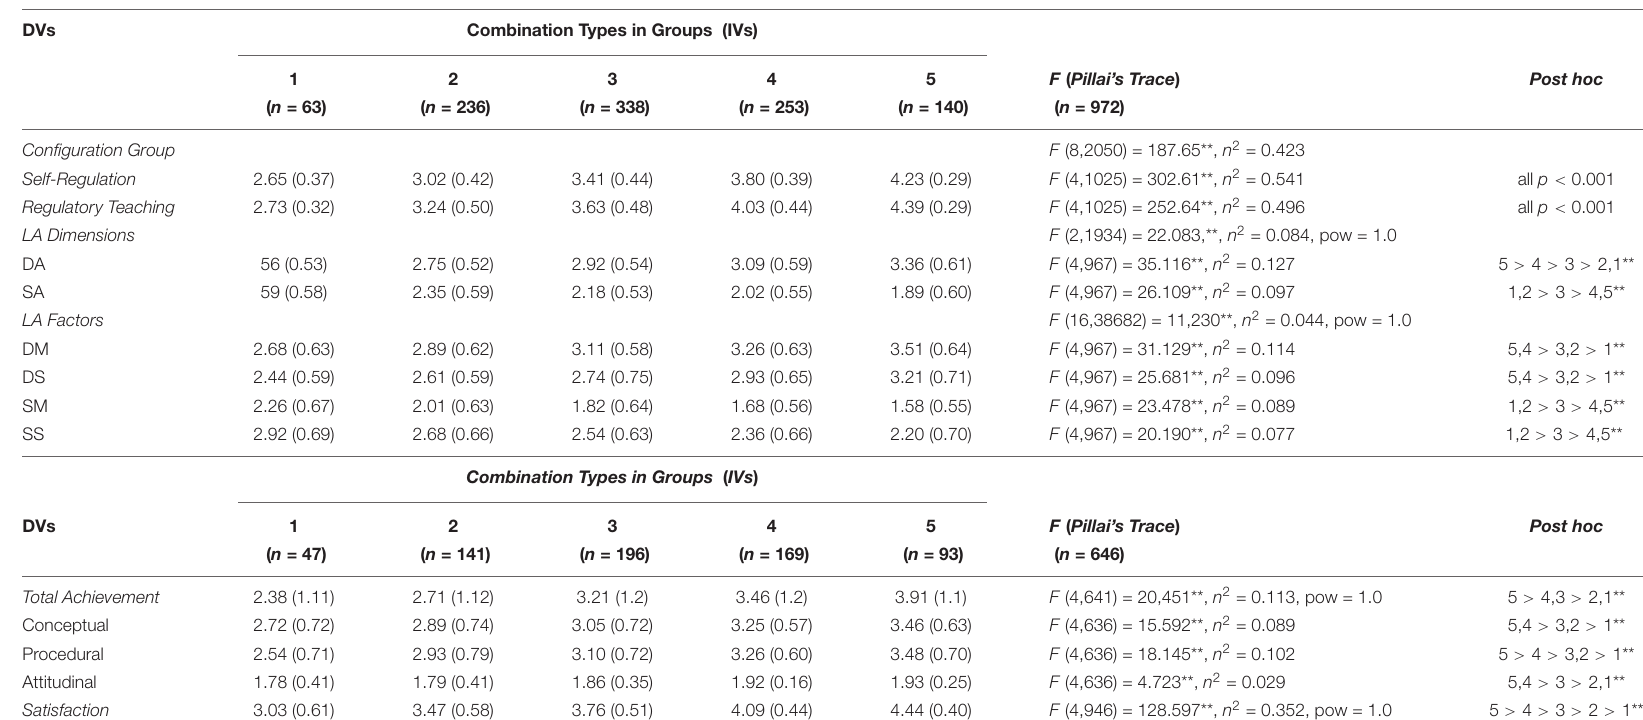
TABLE 4 | Effects of the Five Types of Combinations on Learning Approaches (LA) and Academic Achievement and Satisfaction .